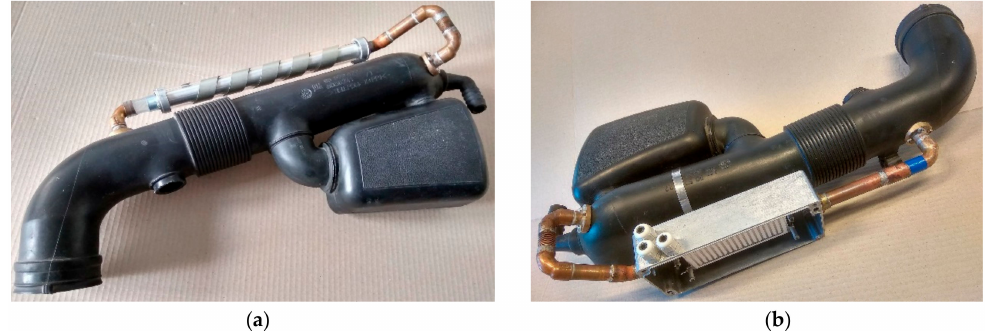
Figure 3. Hardware approach to process automotive engine intake air using manifold by-pass and non-thermal plasma / ozone generated in: ( a ) volume DBD, ( b ) SDBD.